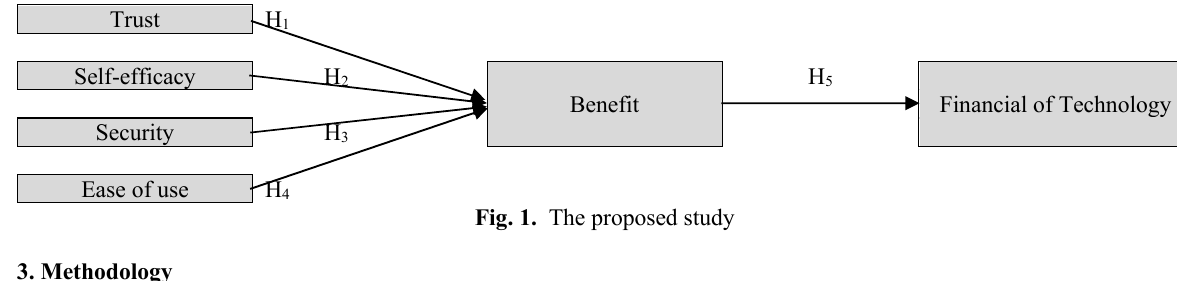
Fig. 1 draws the Research Model Framework, in which online transportations are affected by trust, self-efficacy, security, ease of use, in the model, benefits in this framework as the mediation for financial technology.